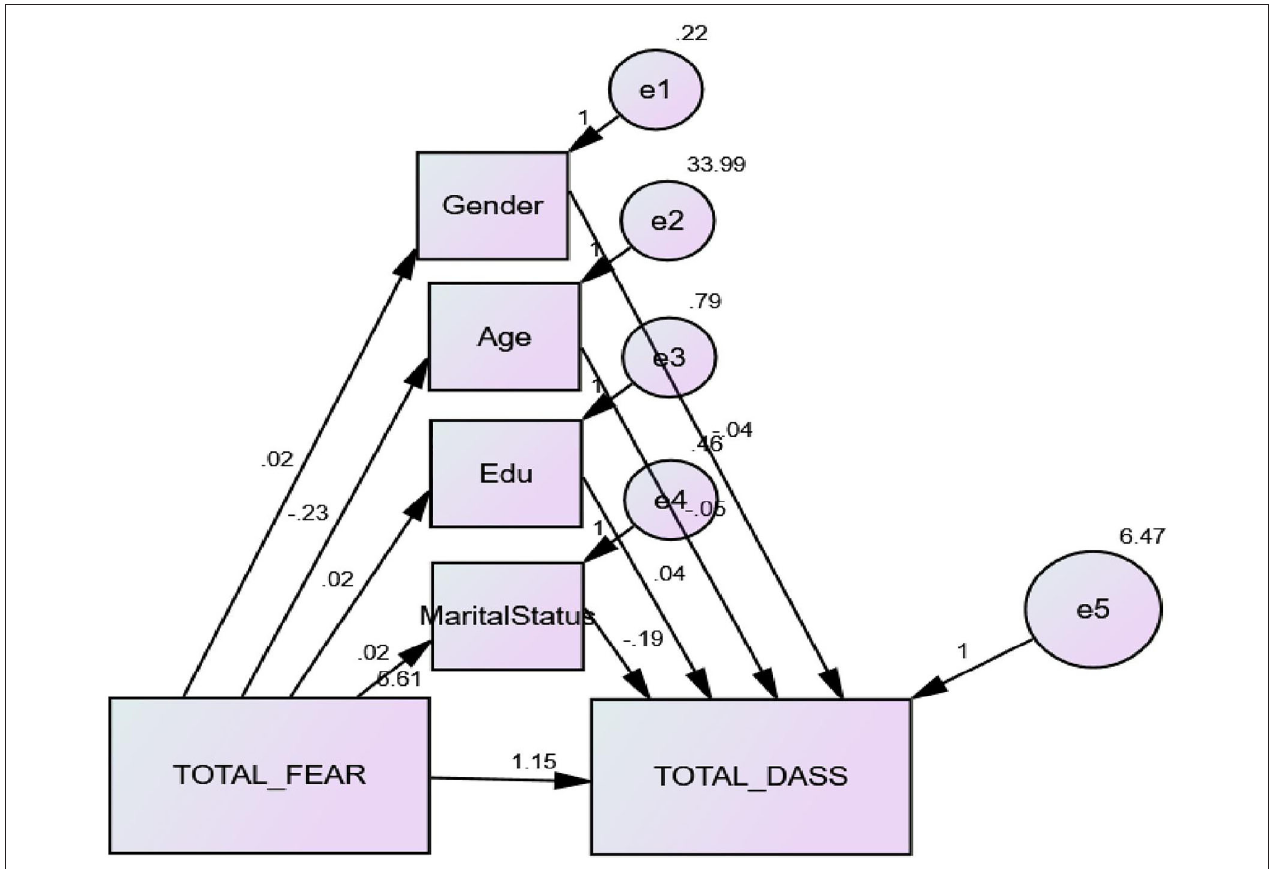
FIGURE 3 | Mediation model of predictive association between study variables ( N = 500).